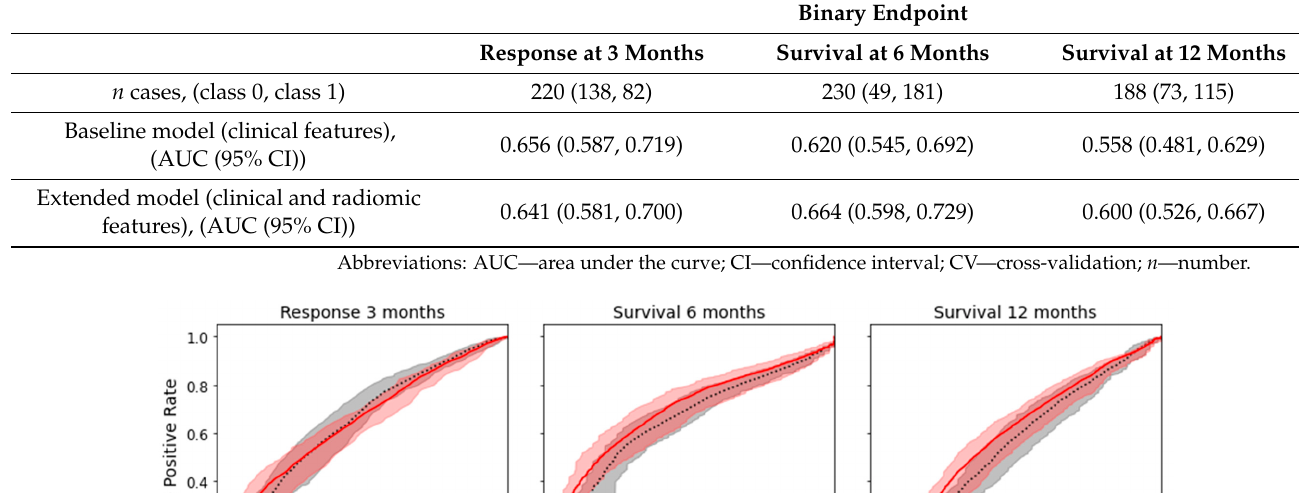
Table 2. Number of cases with class distributions, and mean AUC from a 10 × 5-fold CV and 95% confidence interval computed by bootstrapping the 10 × 5-fold CV.